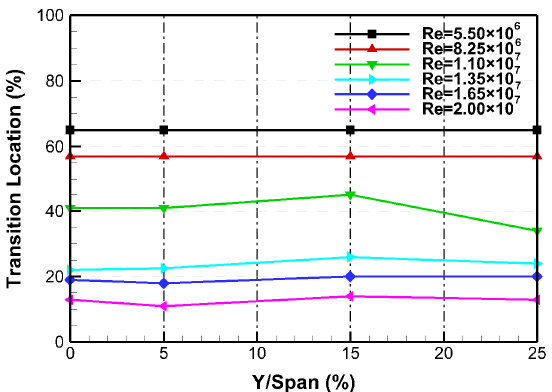
Figure 15. Comparison of the transition location of the central experiment wing with different Re .